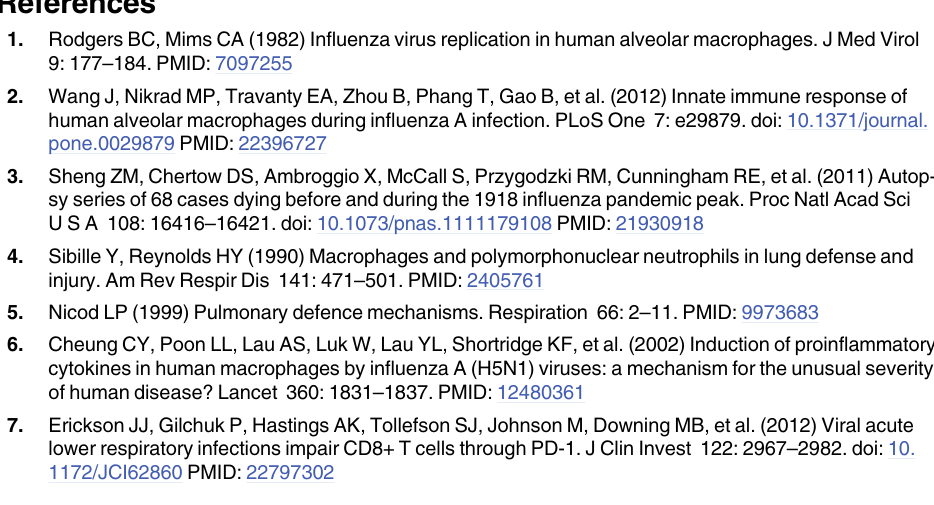
S2 Fig. Infection of MDM by RSV. After infection with RSV, MDM were lysed and expression of A) RSV-N gene at 2 h and 24 h post infection, B) IFN β gene expression at 24 h and C) PDL1 gene expression were measured by RT-PCR and normalized to b2-microglobulin. Data are ex- pressed as mean ± SE 2^-delta Ct values of 7 independent experiments. (cid:1) P < 0.05, (cid:1)(cid:1) P < 0.01. (PPTX) S3 Fig. Analysis of sensitivity of lymphocytes to X31 infection. A) MDMs or lymphocytes were treated with UVX31 or X31 for 2 h before washing. 5 x 10 4 MDMs were added to wells of an ELISPOT plate and were co-cultured with 2.5 x 10 5 lymphocytes. Wells not containing MDMs (T only), and wells containing MDMs only were also measured for their ability to pro- duce IFN γ . The ELISPOT plate was incubated at 37°C for 18 h before analysis. Mean and SEM shown of 3 independent experiments. Paired students t test was performed. p < 0.05 ( (cid:1) ). B) Graph showing mean percentage (± SE n = 3 independent experiments) infection of CD14 + monocytes, CD4 + and CD8 + T lymphocytes fractions of PBMC cultures exposed to increasing concentrations of X31 influenza virus for 20 h as assessed by flow cytometry. C) Representative FACS plots of 3 independent experiments at the highest dose of virus used are shown.